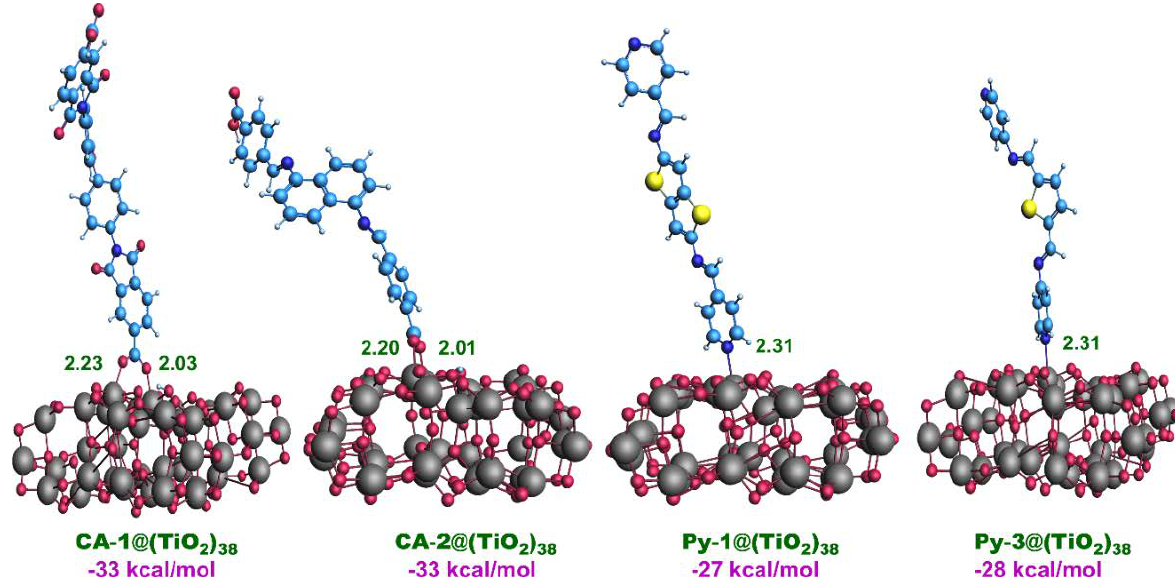
Figure 8. Optimized geometrical configurations of dyes adsorbed onto the surface of (101) anatase (TiO 2 ) 38 cluster along with calculated adsorption energies (kcal/mol) and the distance from the receptors to the surface of TiO 2 (Ti–O and Ti–N, Å).